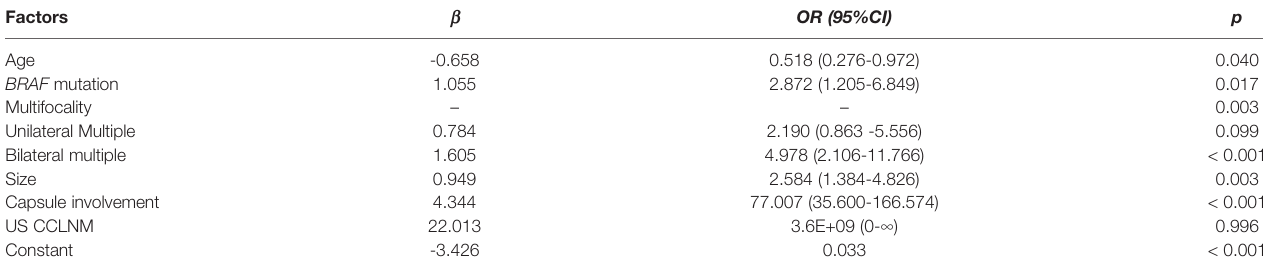
TABLE 4 | Model based on the independent predictors.